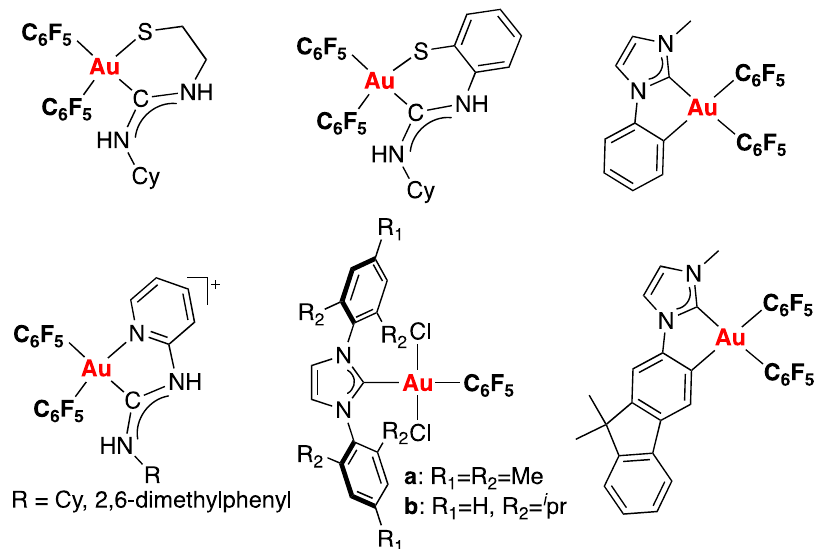
Figure 2. Several gold(III)–carbene complexes containing the pentafluorophenyl group.